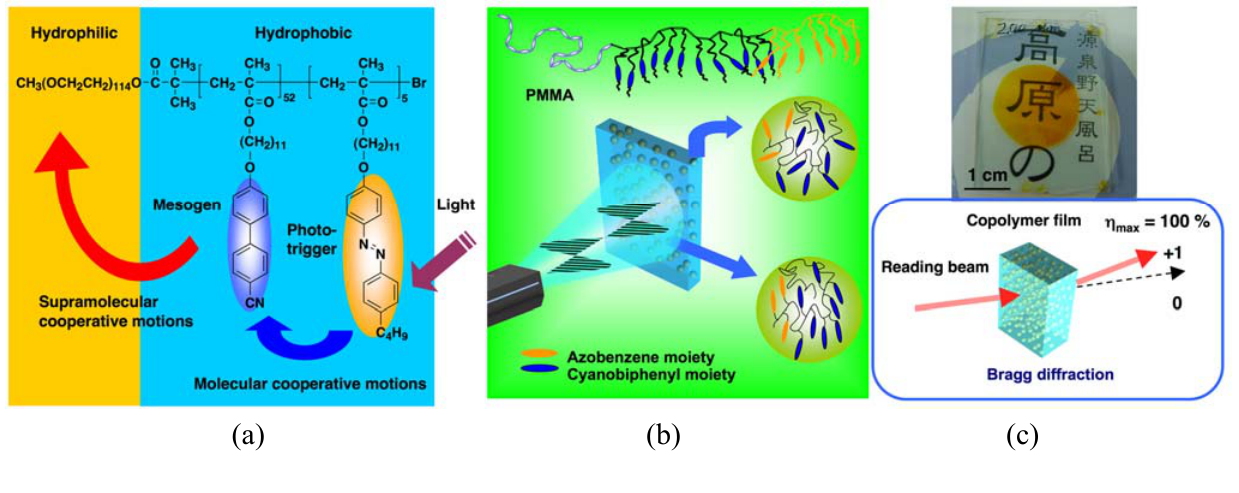
Figure 8. Photoinduced MCM and SMCM of PRBCs. A PRP forms the majority phase (a) and the minority phase (b), respectively. (c) A photograph of a PRBC film with 200  m thickness (left) and scheme of the recorded Bragg grating